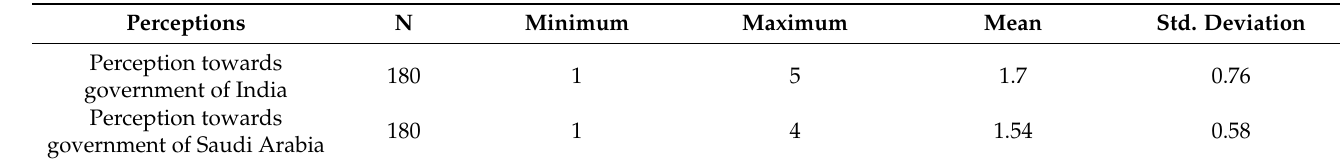
Table 7. Combined mean of the perceptions.